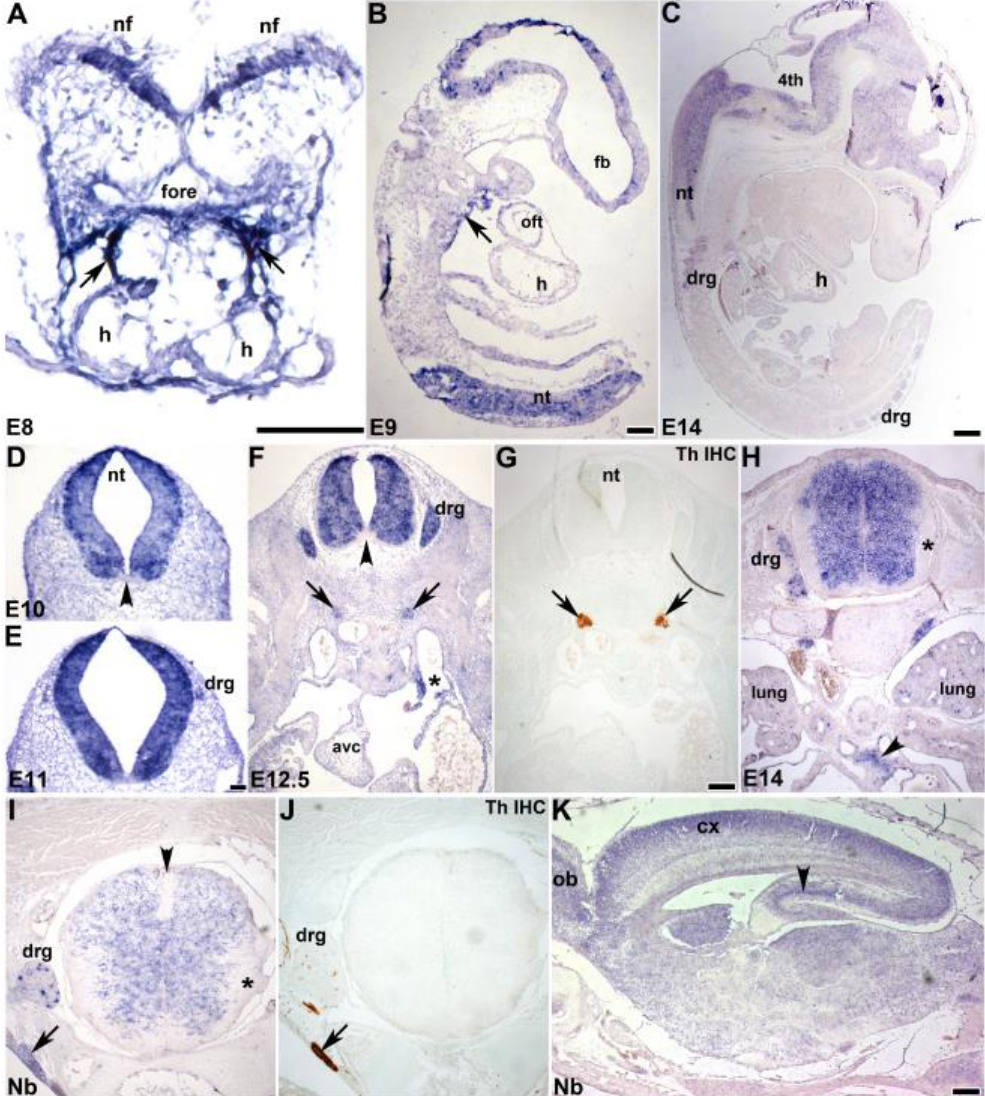
Figure 2. Developmental analysis of mKiaa1211 expression. ( A ) Non-radioactive in situ hybridization detection using digoxigenin (DIG)-labeled mKiaa1211 antisense cDNA probe on E8 transverse sections revealed mRNA expression (purple/blue stain) in neural folds (nf) and second heart field (SHF)/first branchial arch/outflow tract region (arrows), where the primitive tubular heart attaches to the pharyngeal foregut (fore). ( B ) At E9, mKiaa1211 is present in sagittal sections in the neural tube (nt) and fore- and hindbrain, as well as in the branchial arch/second heart field region (arrow). ( C ) Similarly, mKiaa1211 is present in the sagittal E14 section neural tube, hindbrain, and brain, as well as the dorsal root ganglia (drg). ( D – K ) mKiaa1211 is expressed throughout the transverse E10 ( D ), E11 ( E ), and E12.5 neural tubes ( F ), except in the floor plate (arrowhead ( D , F )); but is lost in the fetal and newborn (Nb) marginal layers (* H , I ) and roof plate (arrowhead ( I )) of the central nervous system spinal cord. In newborn sagittal brain, mKiaa1211 is present in cortex (cx), olfactory bulb (ob), and hippocampus (arrowhead ( K )). mKiaa1211 is also expressed as the dorsal root ganglia are formed (E11 – birth), and during morphogenesis of tyrosine hydroxylase (TH)-positive ganglia ( G ) of the sympathetic nervous system (( F – J ) arrows). mKiaa1211 is detectable in the embryonic sinus venosus (* F ) and fetal vagal (X) trunks (arrowhead ( H )), along with some punctate expression in E14.5 lung ( H ). Scale bars: ( A , B , F – H ) = 100 µm; ( C – E ) = 50 µm; ( K ) = 200 µm. Abbreviations: avc — atrioventricular cushion; 4th — fourth ventricle; fb — forebrain; h — heart; oft — outflow tract; v — heart ventricle.